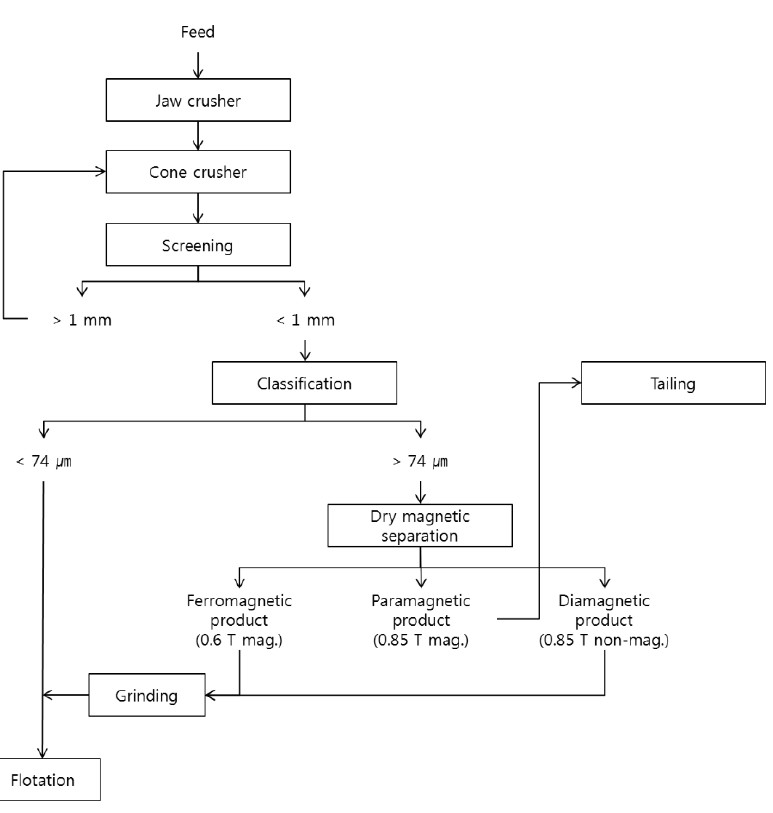
Figure 8. Flowchart of pre-concentration process using magnetic separation. Table 5. Results of pre-concentration process of target elements.